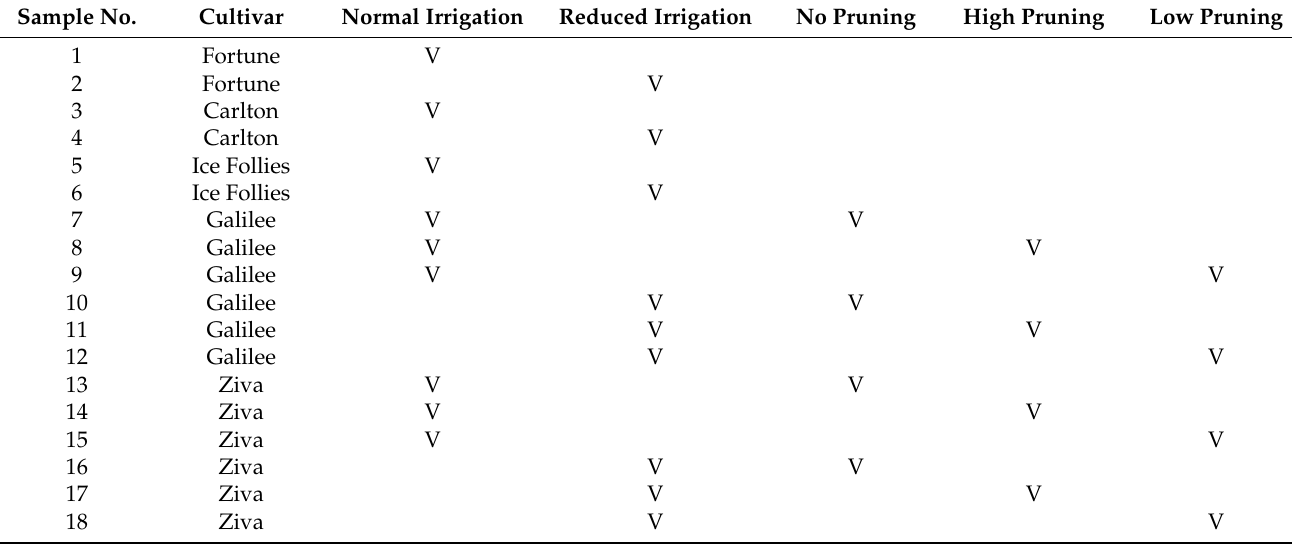
Table 2. Irrigation and pruning levels during Narcissus cultivar